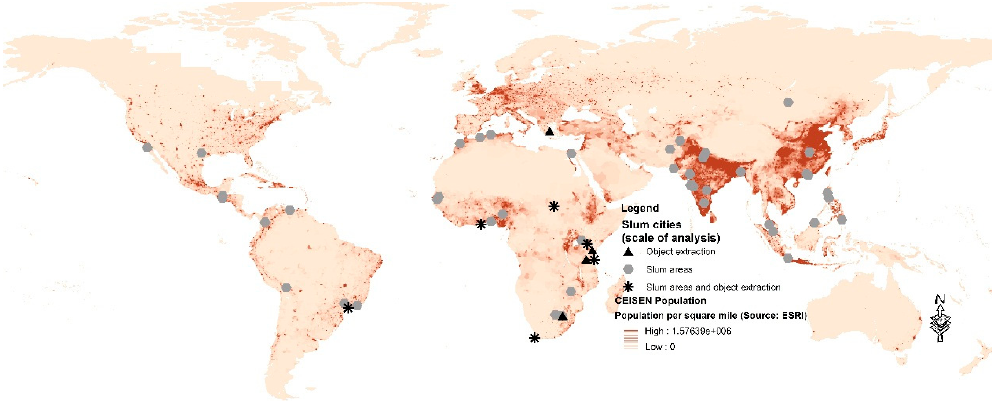
Figure 3. Case study cities in publications ( N = 87) on slum mapping via RS methods on top of a population density map (base map: population density, Source: ESRI).